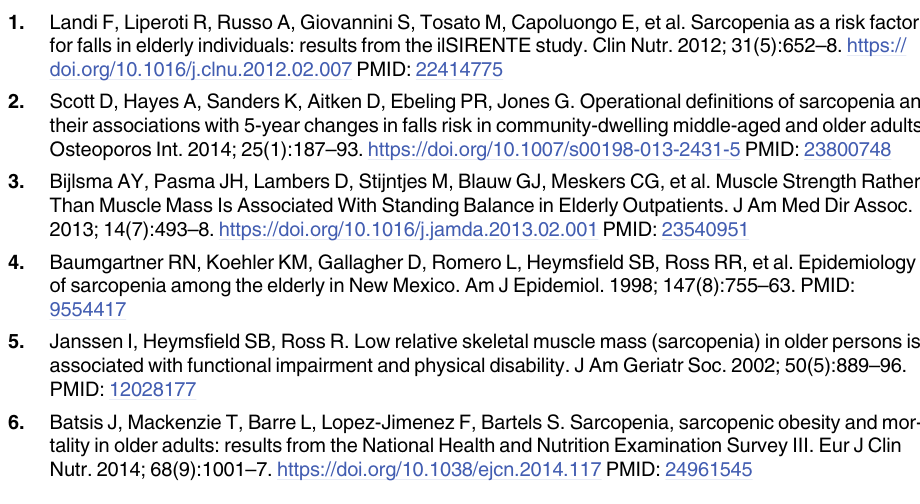
S2 Table. Management of sarcopenia depicted as consulted healthcare professionals for interventions before and directly after attendance, total and stratified by group of health- care